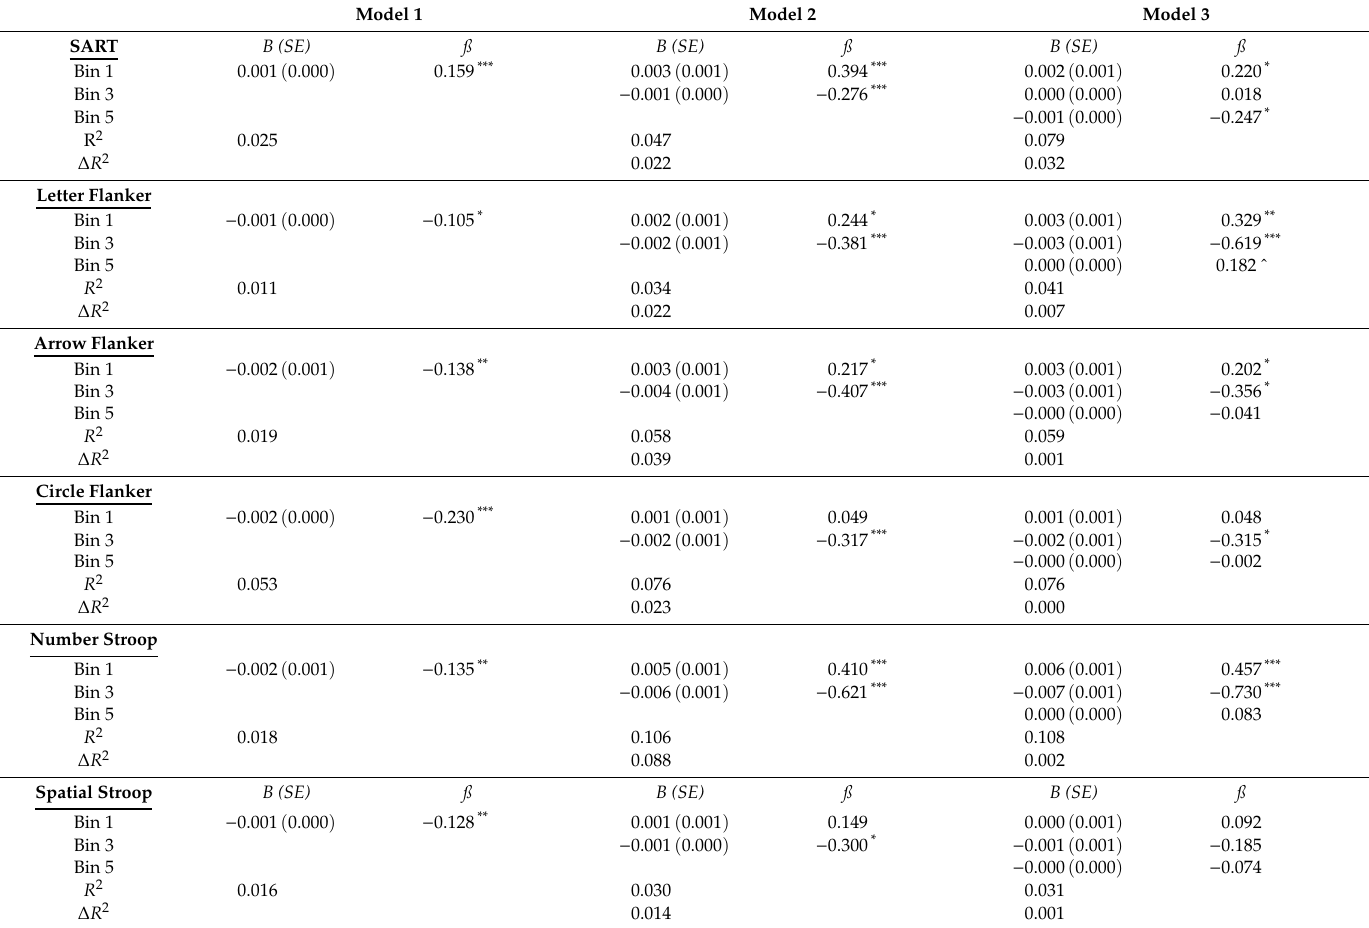
Table 3. Hierarchical regressions of WMC regressed on Bins 1, 3, and 5, for each